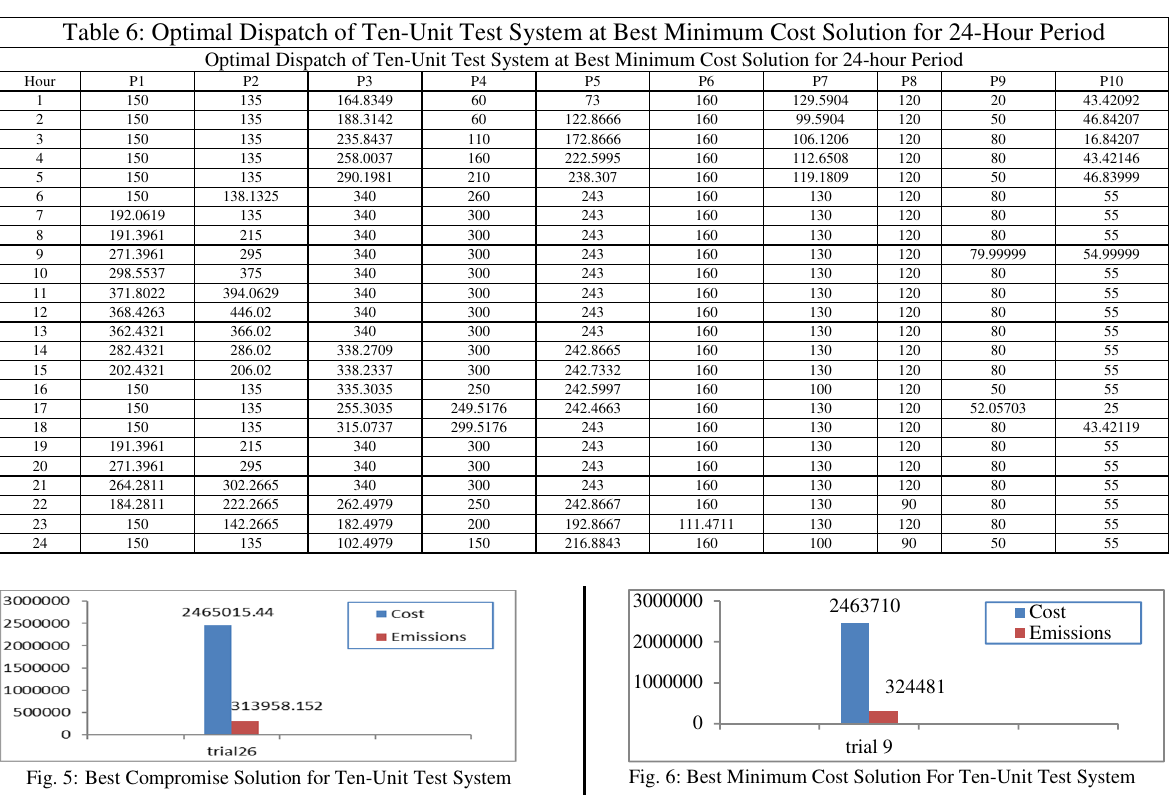
Table 6: Optimal Dispatch of Ten-Unit Test System at Best Minimum Cost Solution for 24-Hour